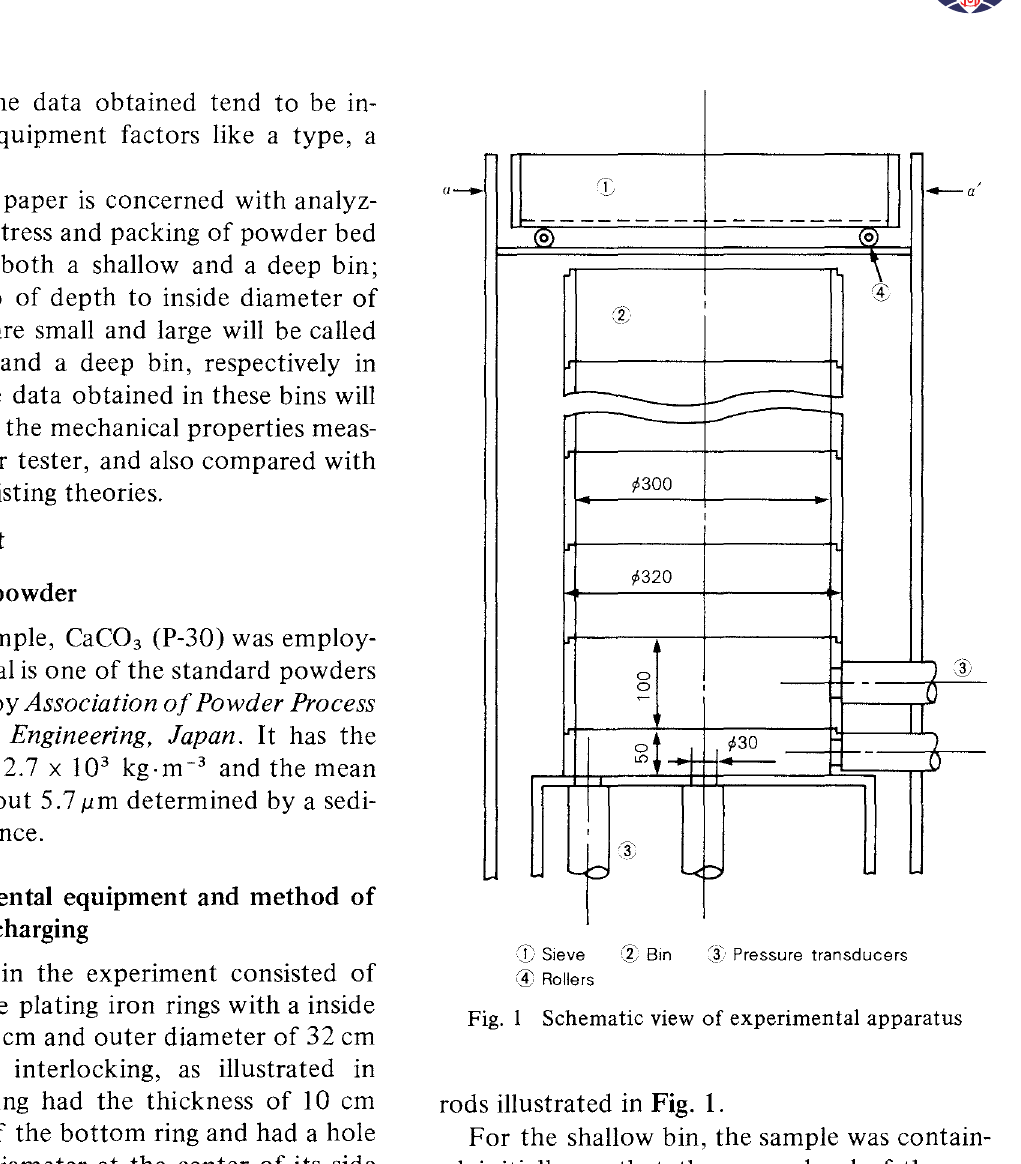
Fig. 1 Schematic view of experimental apparatus